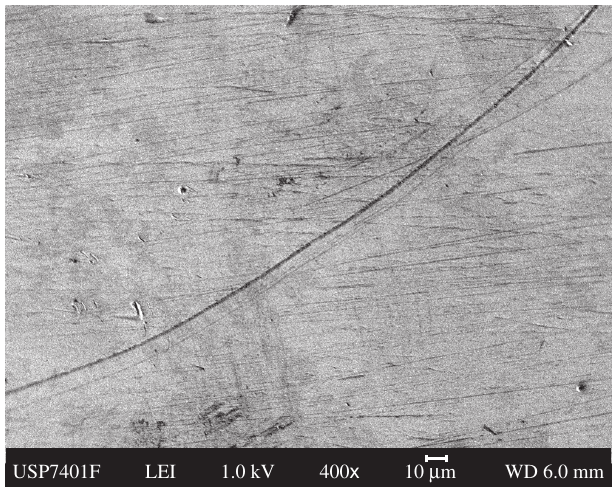
Figure 1. Typical SEM obtained for pure Ti surface. Scanned area corresponds to 230 x 319 μ m.